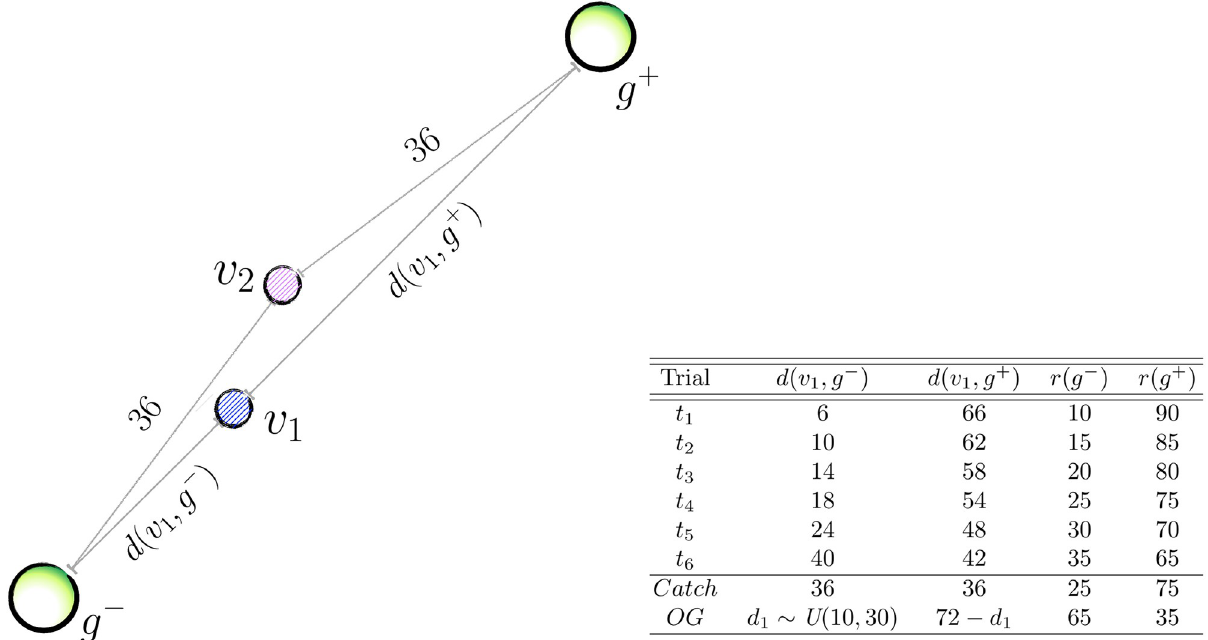
Fig 2. Illustration of double-goal trials (DGTs). Vehicles’ colours in this figure are random. d ( v 1 , g − ) and d ( v 1 , g + ) indicate the Manhattan distances (in units of the vehicle’s step size) from vehicle v 1 to both g − and g + . Vehicle v 2 ’s distance from both goals is constant, i.e. d ( v 2 , g − ) = d ( v 2 , g + ) = 36. The last two columns indicate the monetary reward (in pence) associated with each goal, i.e. r ( g − ) and r ( g + ). The theme underpinning the design is, the closer a vehicle is to g − , the less rewarding r ( g − ) will be, and the more rewarding r ( g + ) will be. In this illustration, we arbitrarily placed v 1 asymmetrically (closer to g − ), and v 2 at the center of the canvas. Recall, however, that all trials showed in the Table appear twice in every block, the second time with vehicles’ positions swapped. This was done to ensure that we can fully orthogonalise rewards, distances and guidabilities. Thus, if we first encounter trial t 4 with v 2 at the center of the canvas (as is shown), the second time we meet this trial type the vehicles’ positions will be swapped (and the canvas randomly rotated) and v 2 will be the one closer to g − . Catch and OG trials are atypical, and test participants’ notion of the vehicles’ guidabilities, and break the inverse correlation of distance and reward imposed by the design of the other trials, respectively. In Catch trials, vehicles are equidistant from both goals, so we expect participants to choose the more guidable vehicle ( v 1 ) and the more rewarding goal. Obvious-goal ( OG ) trials are the only occasion in which r ( g − ) is actually larger than r ( g + ), so that choice should “obviously” be g − . The distance of the closer vehicle to the 65p goal is extracted from a uniform distribution in the indicated set (we used a MatLab notation to denote the sample space); this is the only occasion in which distances are sampled randomly within the design. All DGTs are individually rendered, for clarity, in S1 Fig, where we show a full instance of the first 16 trials in a block. An OG trial is also shown in Fig